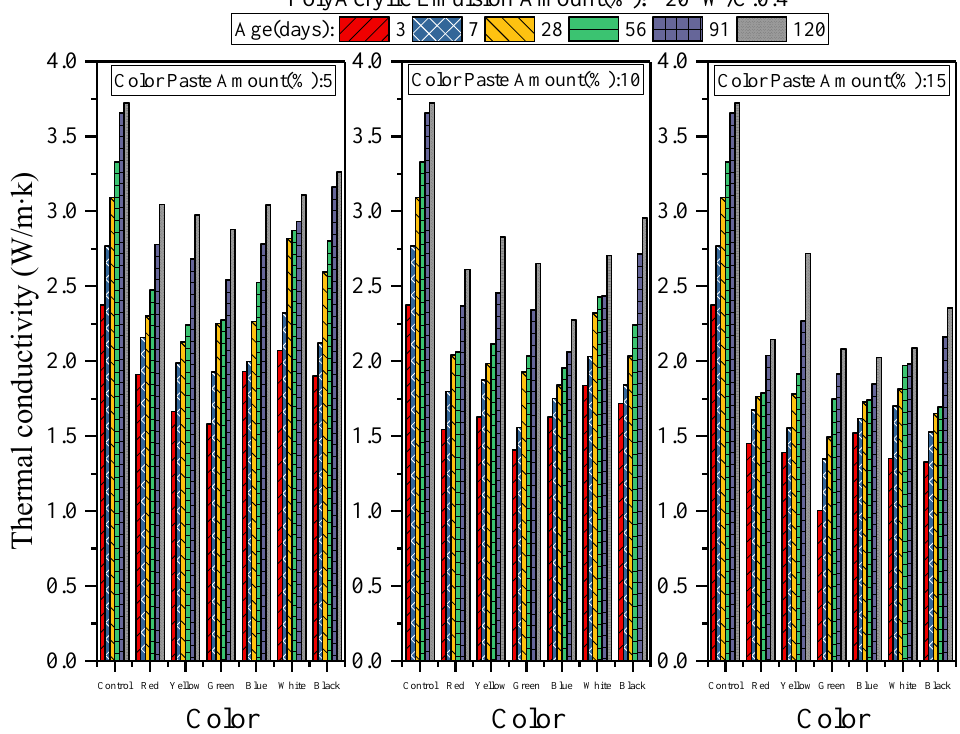
Figure 10. W/C 0.4 Thermal conductivity of mortar with different proportions of inorganic color paste. (9) Length